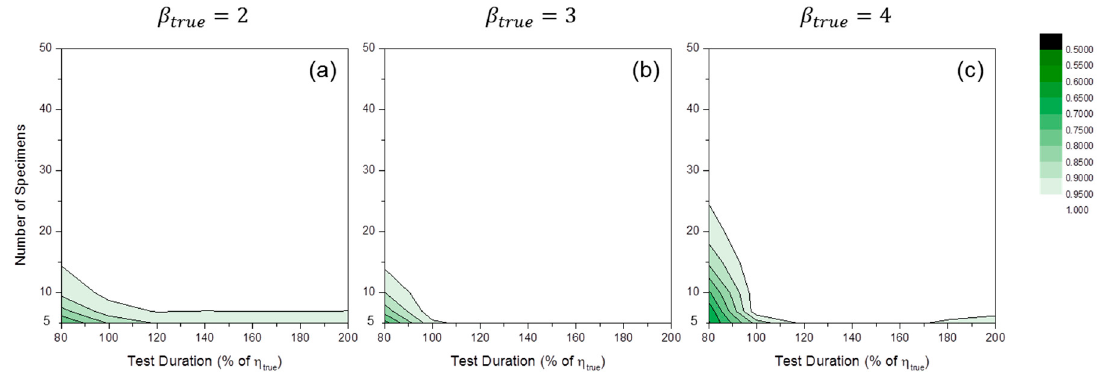
Figure 11. Convergence ratio distributions of MLE numerical estimation at: ( a ) (cid:2010) (cid:3047)(cid:3045)(cid:3048)(cid:3032) = 2 ; ( b ) (cid:2010) (cid:3047)(cid:3045)(cid:3048)(cid:3032) = 3 ; and ( c ) (cid:2010) (cid:3047)(cid:3045)(cid:3048)(cid:3032) = 4 (censoring interval: 20% of (cid:2015) (cid:3047)(cid:3045)(cid:3048)(cid:3032) ).